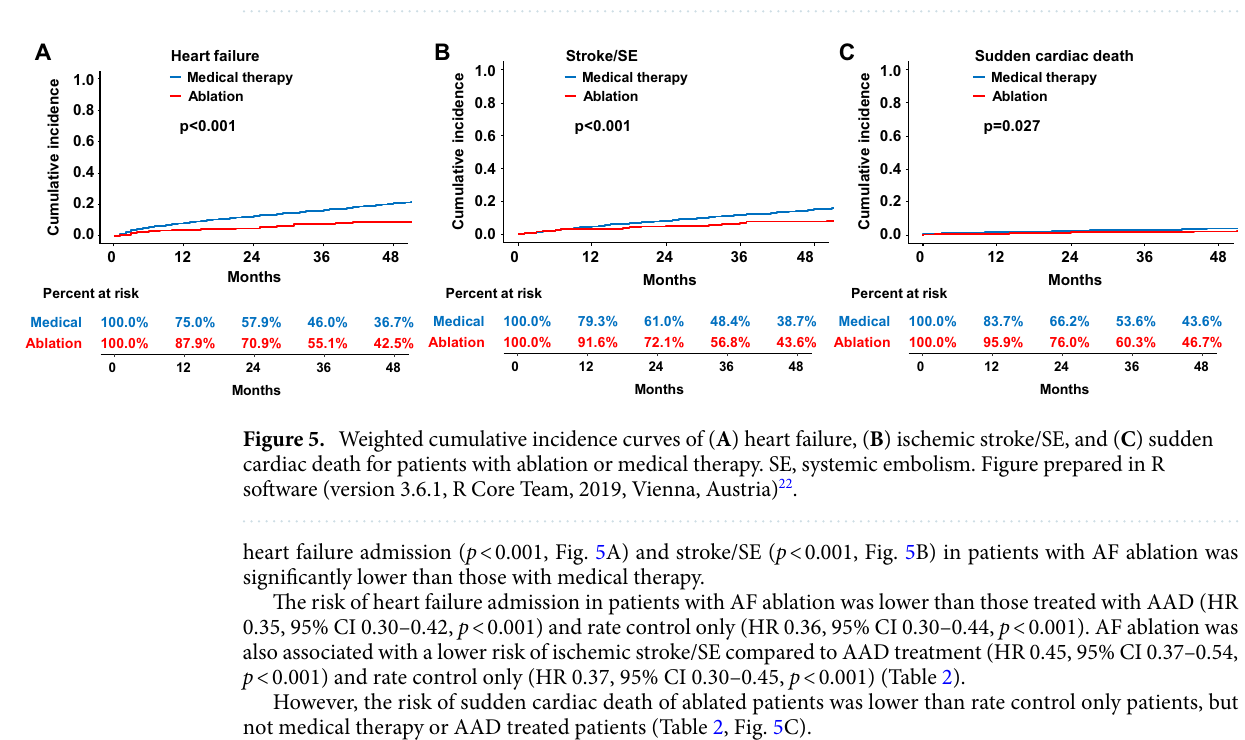
Figure 4. Subgroup analyses of the risk of cardiovascular death. HR, hazard ratio, TIA, transient ischemic attack, OAC, oral anticoagulant.